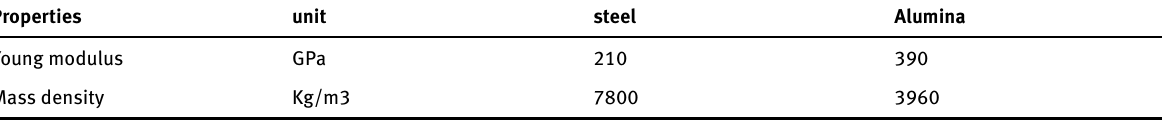
Table 2: Material properties of FGM beam (Alshorbagy 2011)